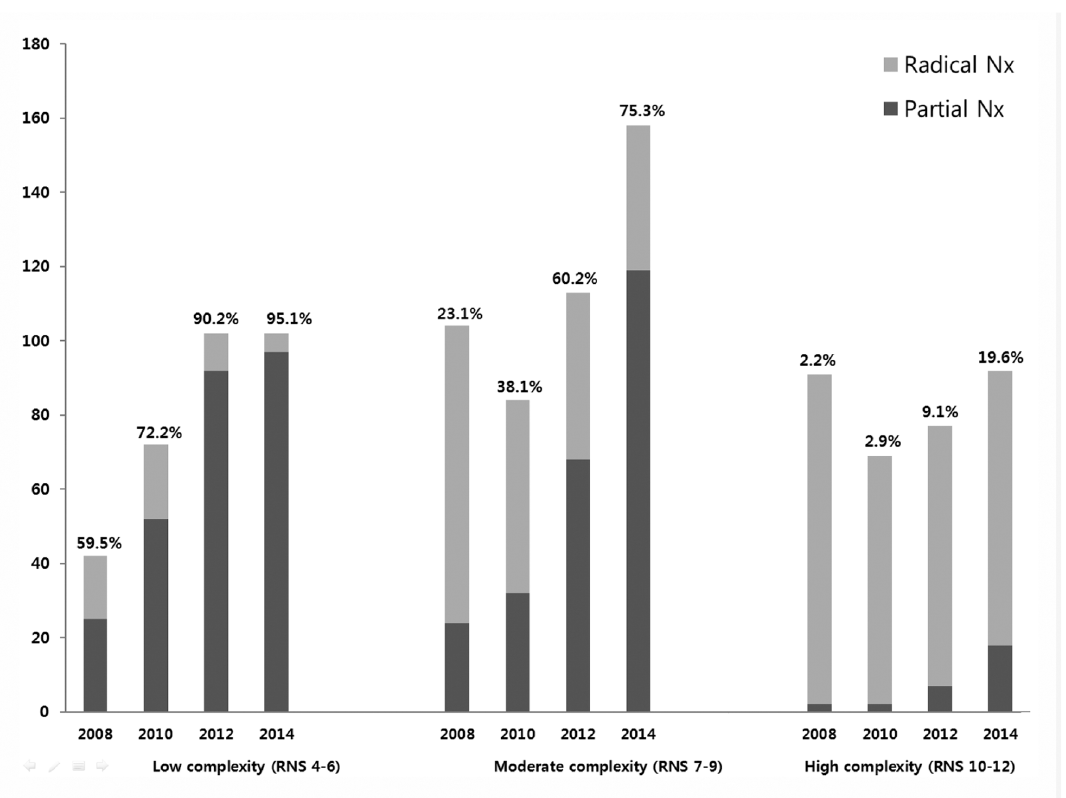
Fig 2. Radical nephrectomy and partial nephrectomy in each RNS group by year. * The percentage of partial nephrectomy is indicated above each bar.